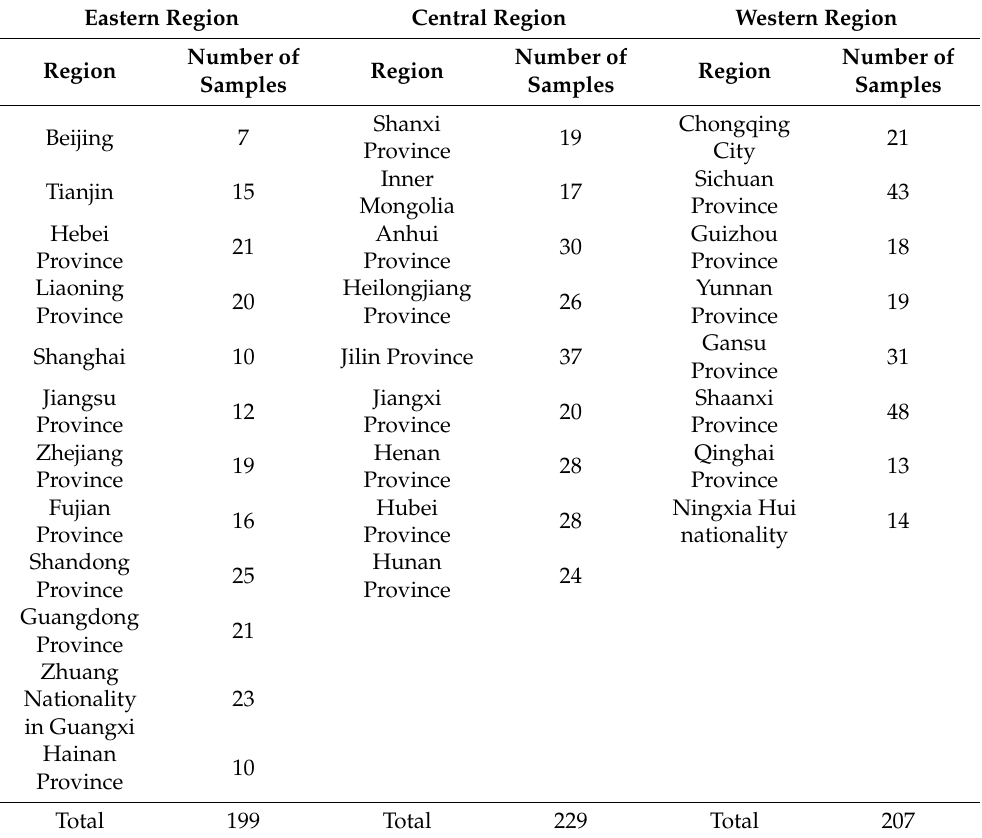
Table 1. Regional distribution of sample